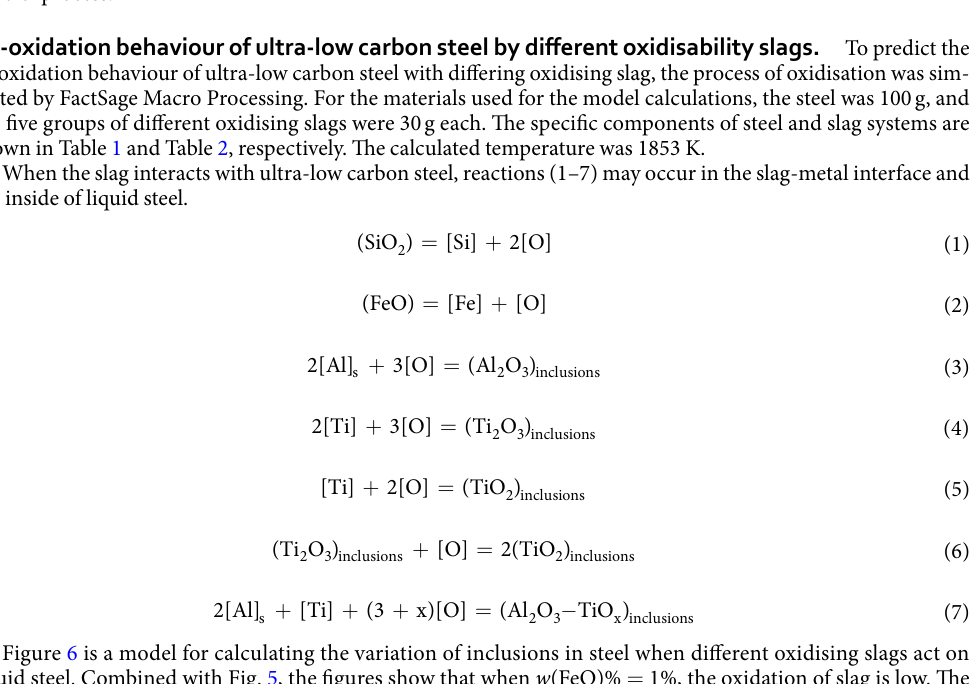
Figure 5 is a comparison of the change value in T.[O] content in the model calculation and the experimentally measured change value when different oxidising slag acts on the liquid steel. The figure shows that as the oxidising property of slag increases, the T.[O] content of steel calculated by the model increases linearly. Under the same conditions, the measured and calculated values show good consistency. This indicates that the kinetic model can control process.